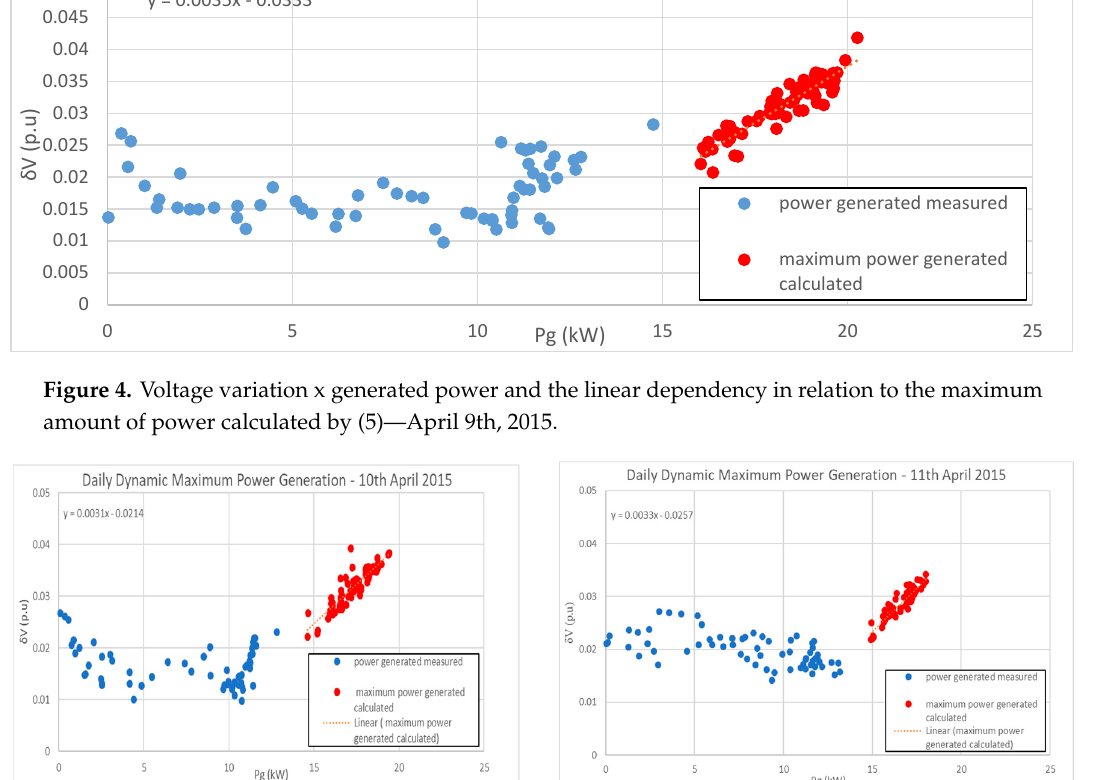
Figure 5. Voltage variation x generated power and the linear dependency in relation to the maximum amount of power calculated by Equation (5) for 10th of April 2015 and 11th of April 2015.